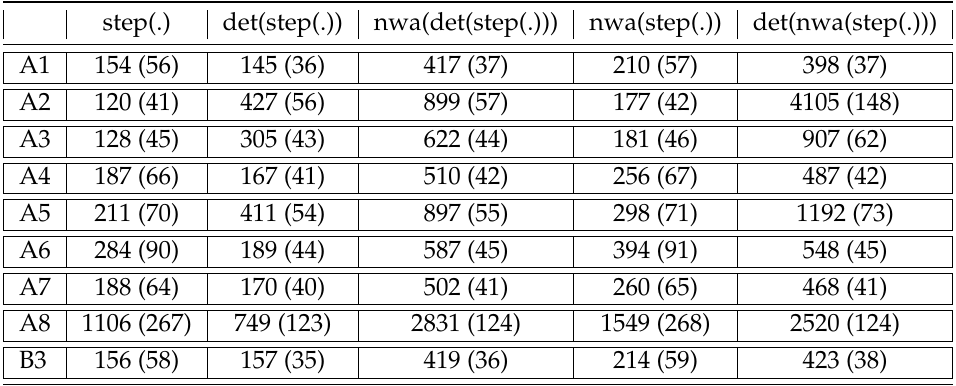
Figure 18. The SHA s for the benchmark NREs and the automata derived